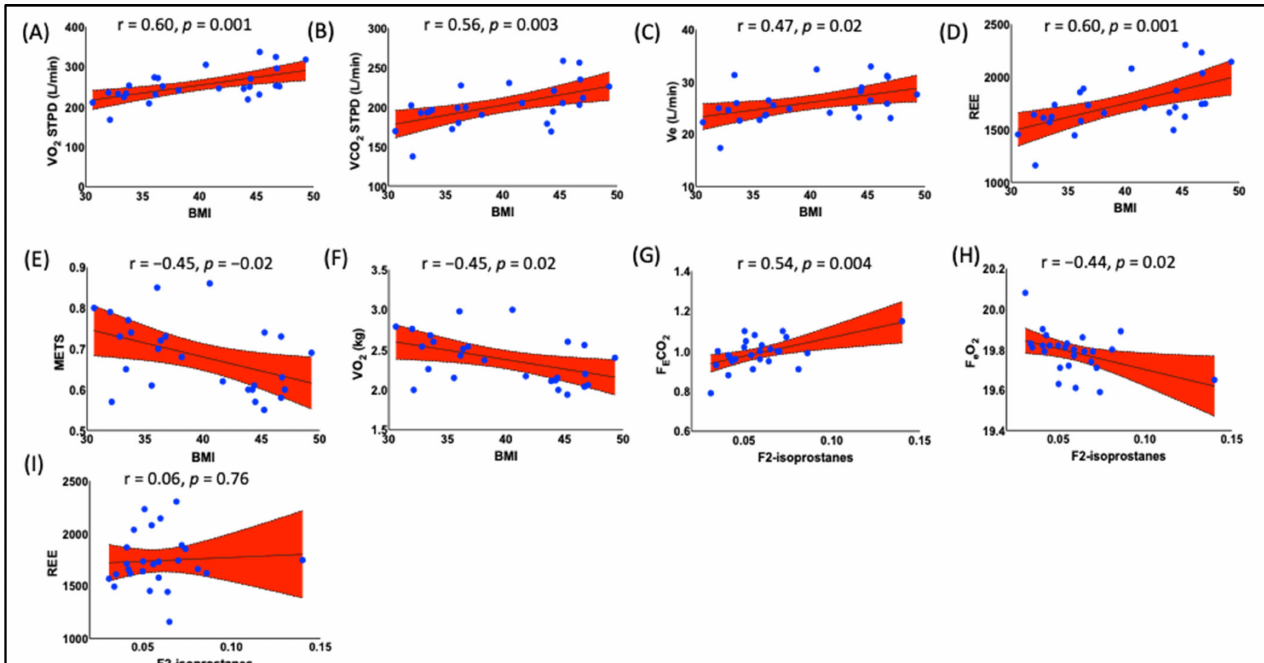
Figure 6. Relationship of specific body circumferences with BMI and F 2 -IsoPs. We found a strong positive correlation between BMI and ( A ) VO 2(STPD) (l/min, r = 0.60, p = 0.001), ( B ) VCO 2(STPD) (l/min, r = 0.56, p = 0.003), ( C ) Ve (l/min, r = 0.47, p = 0.02), and ( D ) REE (kcal, r = 0.60, p = 0.0162), while the inverse correlation with ( E ) METs (r = − 0.45, p = 0.02), and ( F ) VO 2 (kg, r = − 0.45, p = 0.02). There was a positive correlation between F 2 -IsoPs and ( G ) FeCO 2 (r = 0.54, p = 004), while an inverse correlation with ( H ) FeO 2 (r = − 0.44, p = 0.02), and